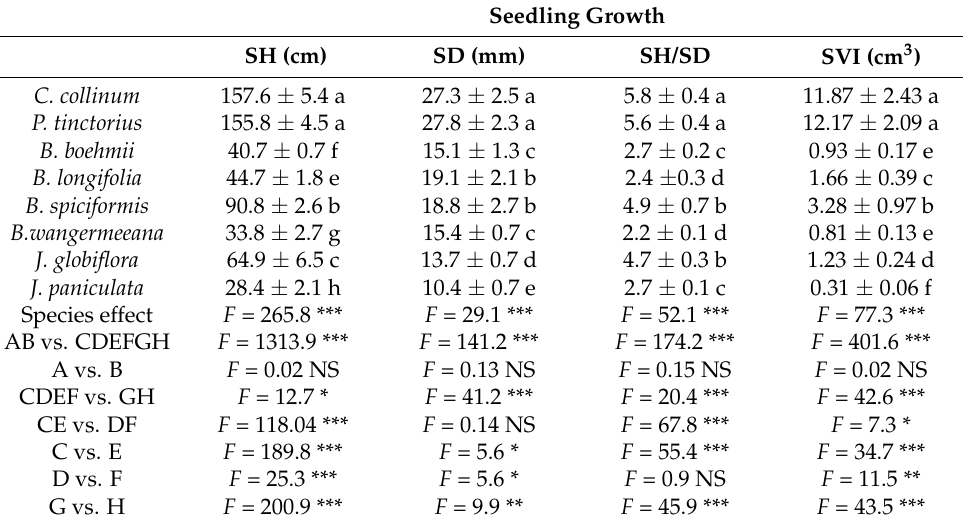
Table 4. Differences in mean ( ± SD) seedling length and diameter growth among eight tree species from woodland (ES versus LS), four years after planting. Means in a given column with the same letter do not differ from one another ( p ≥